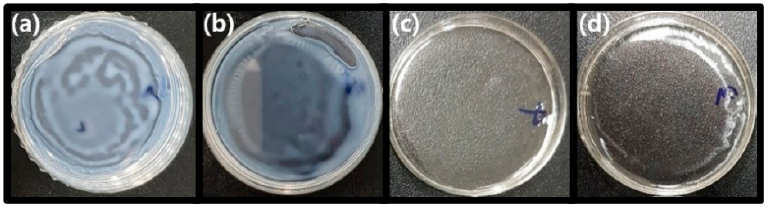
Figure 2. The mixability of WPU and acrylates: ( a , b ) WPU/diacrylate ratio of 1.0 and 0.2; ( c , d ) WPU/triacrylate ratio of 0.3 and 0.2.